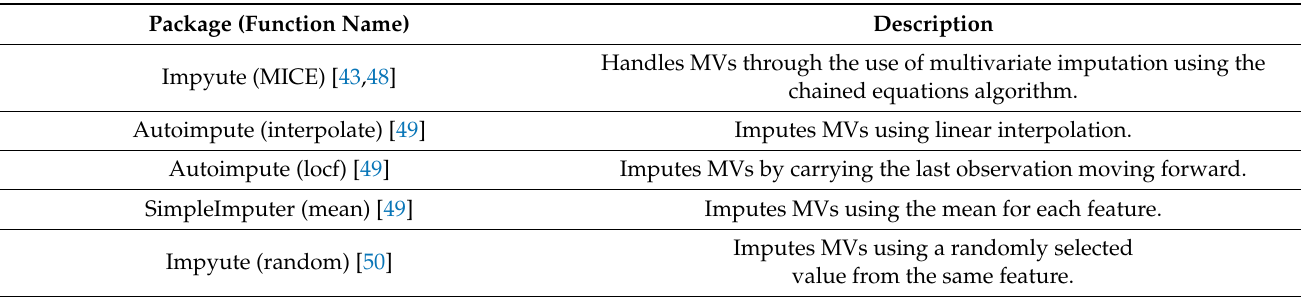
Table 2. The algorithms used in the